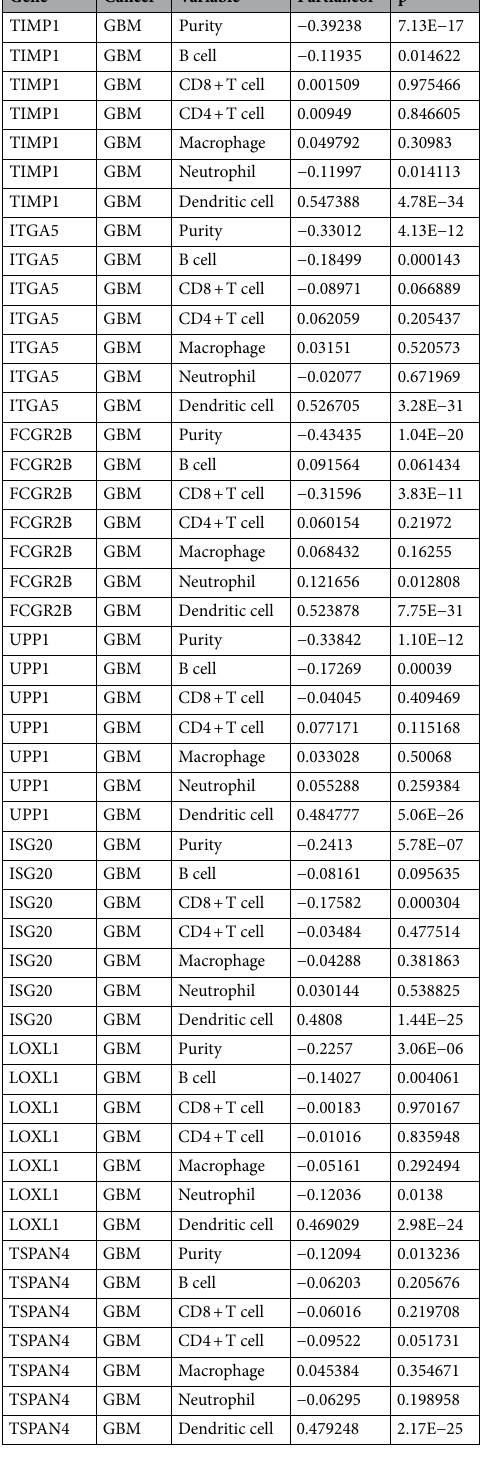
Table 1. TIMER analysis of the correlation between immune infiltration and prognostic